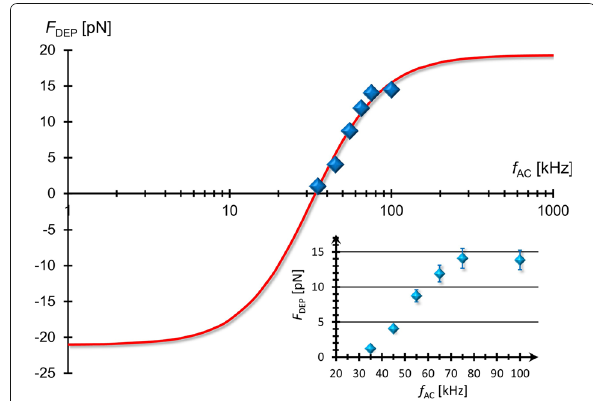
Fig. 5 Frequency dependence of F DEP . The FM-DEP force ( F DEP ) as a function of external frequency ( f AC ) of applied AC field where F DEP has been evaluated from Eq. (12), the balance equation between the FM-DEP and hydrodynamic forces exerted on a single MLV. It can be seen that F DEP is increased and saturated as f AC is higher, reflecting a typical behavior of the relaxation spectrum of the real CM factor. The solid line represents the best-fit result of Eq.